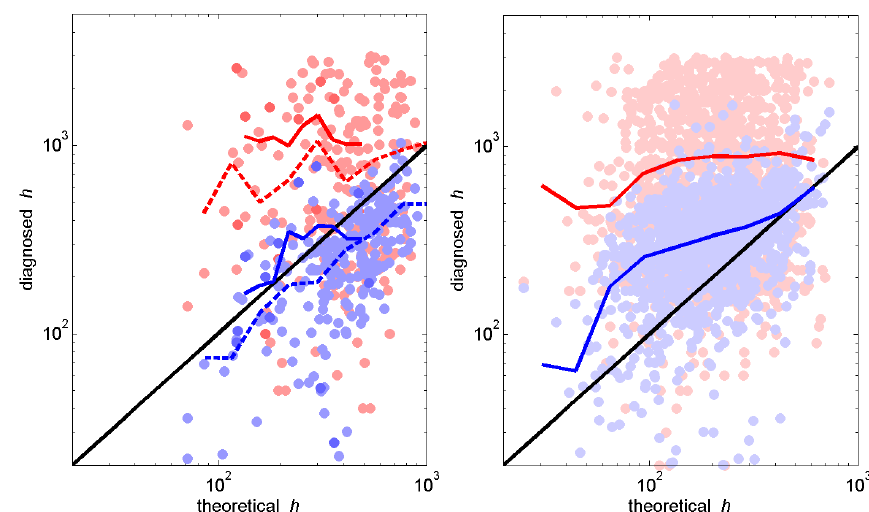
Figure 3. The daily averaged stably stratified quasi-steady state PBL depth, h . Days with convection and Monin-Obukhov length changes larger than ∆ L = 50m per day are excluded. Following Zilitinkevich et al. (2007), data were separated in (a) nocturnal (solid curves; light dots) and conventionally neutral (dashed curves; dark dots) PBLs; (b) long-lived stably stratified PBL. Bluish dots and blue curves are the ERA-40 data. Reddish dots and red curves are the CHAMP data. The curves are the bin-averaged values of the corresponding